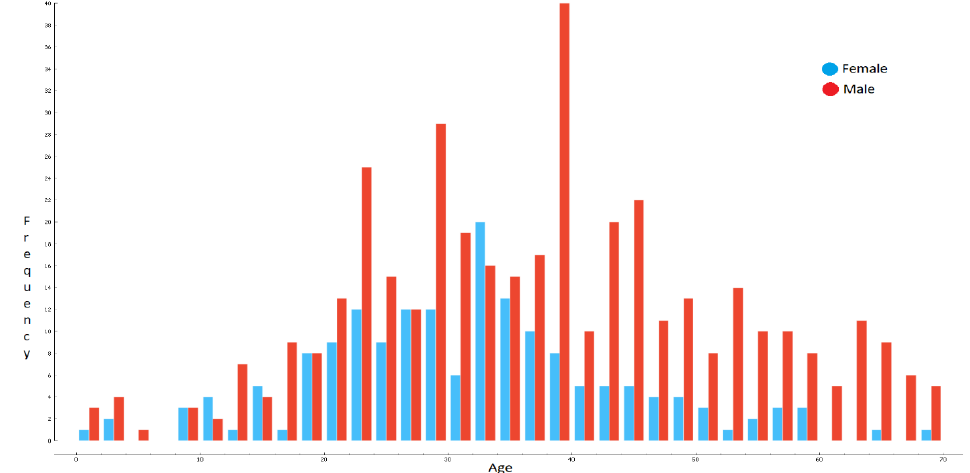
Figure 4. Prevalence of disease against genders.